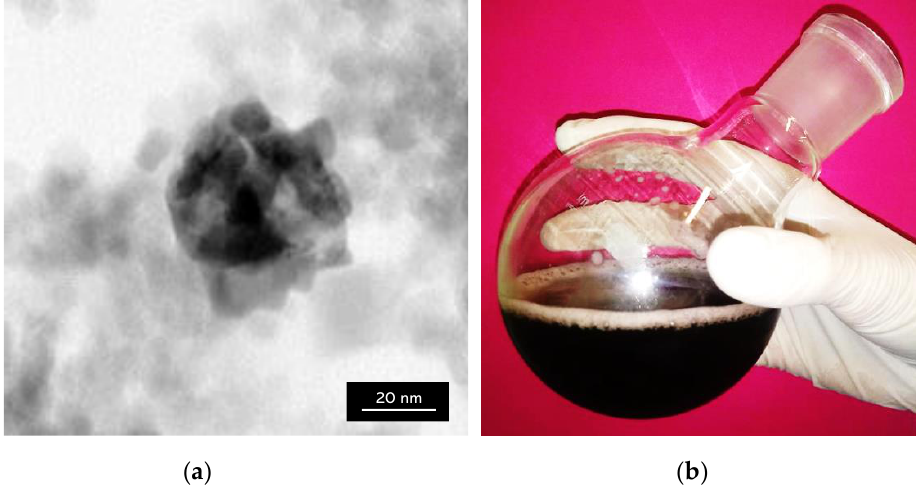
Figure 10. ( a ) TEM (Transmission Electron Microscopy) image of Fe 3 O 4 @Ag nanoparticles; ( b ) Fe 3 O 4 @Ag nanoparticles in suspension.